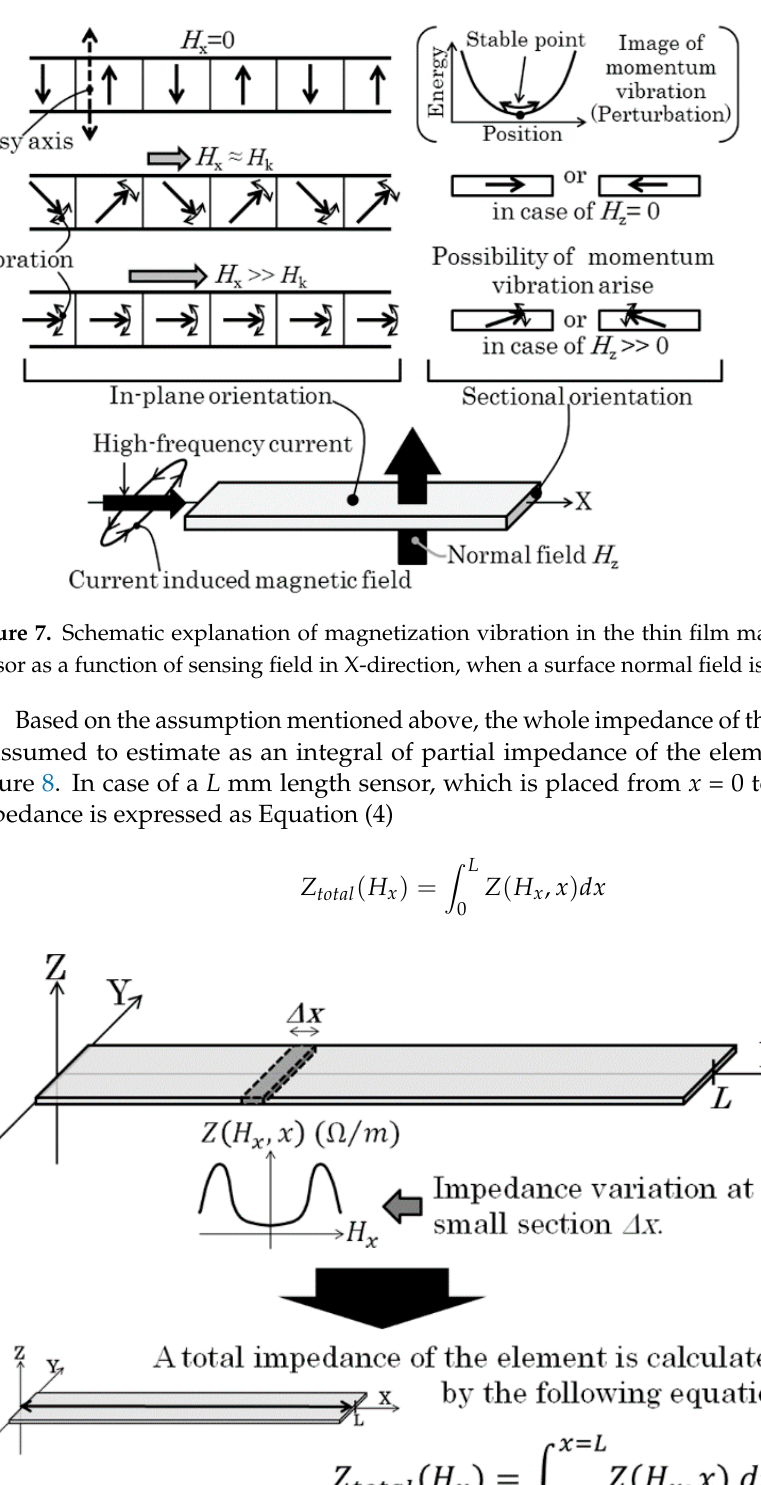
85 Nb 12 Zr 3 element is roughly 20 μ m to 50 μ m which is narrow enough compared with